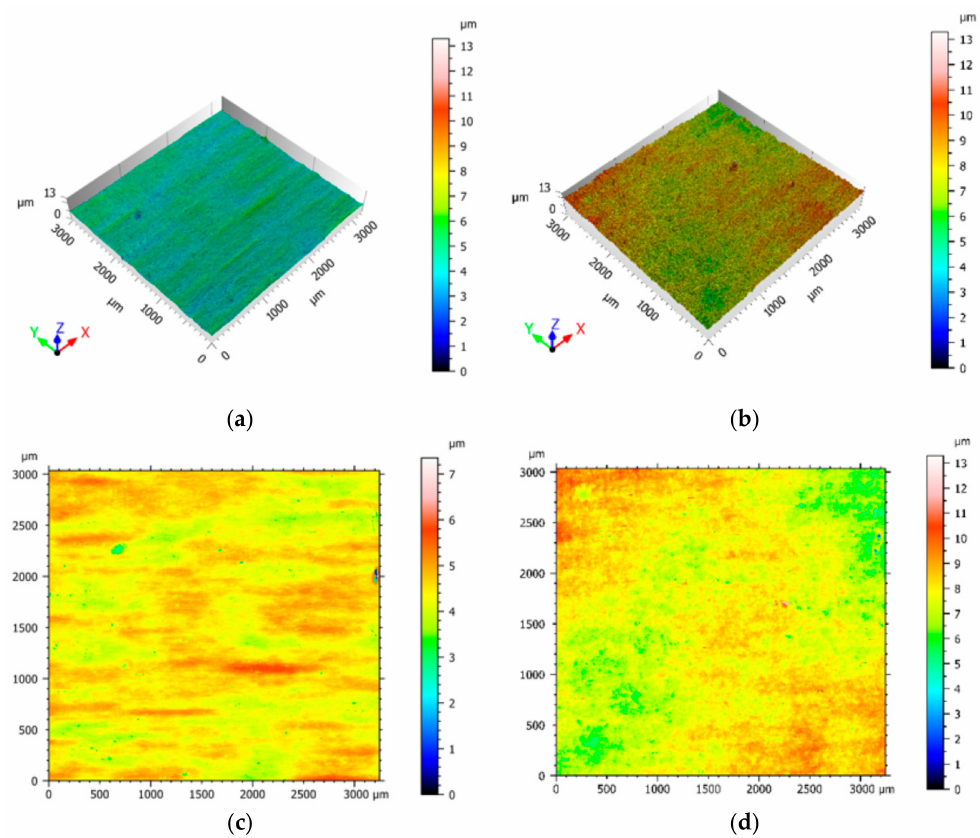
Figure 8. Topographic view of the material surface. ( a , c ) 3D and 2D representations of the surface of the AR material, respectively. ( b , d ) 3D and 2D representations of the surface of the PSTT material, respectively.